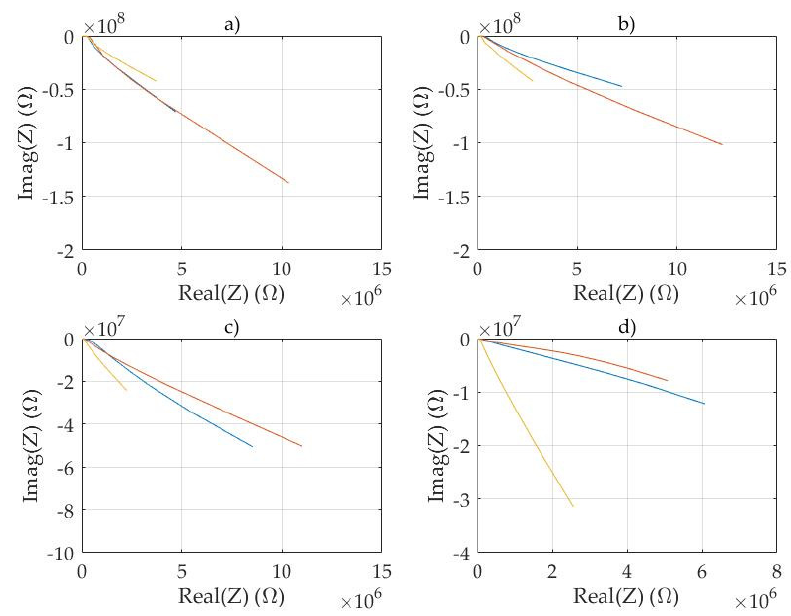
Figure 6. Examples of complex electrical spectra of fresh birch chips and bark: ( a ) Birch wood 100%, ( b ) birch wood 75%, bark 25%, ( c ) birch wood 25%, bark 75% and ( d ) bark 100%. Frequency range 120 Hz–1 MHz. Measurements in x- (red), y- (blue) and z-directions (yellow, top to bottom).